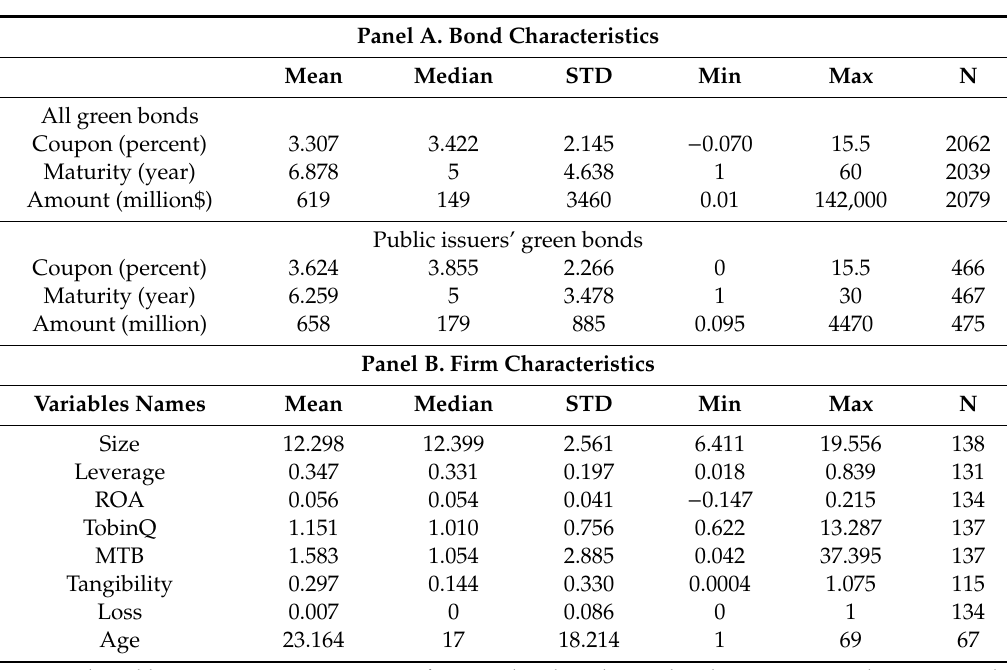
Table 2. Summary